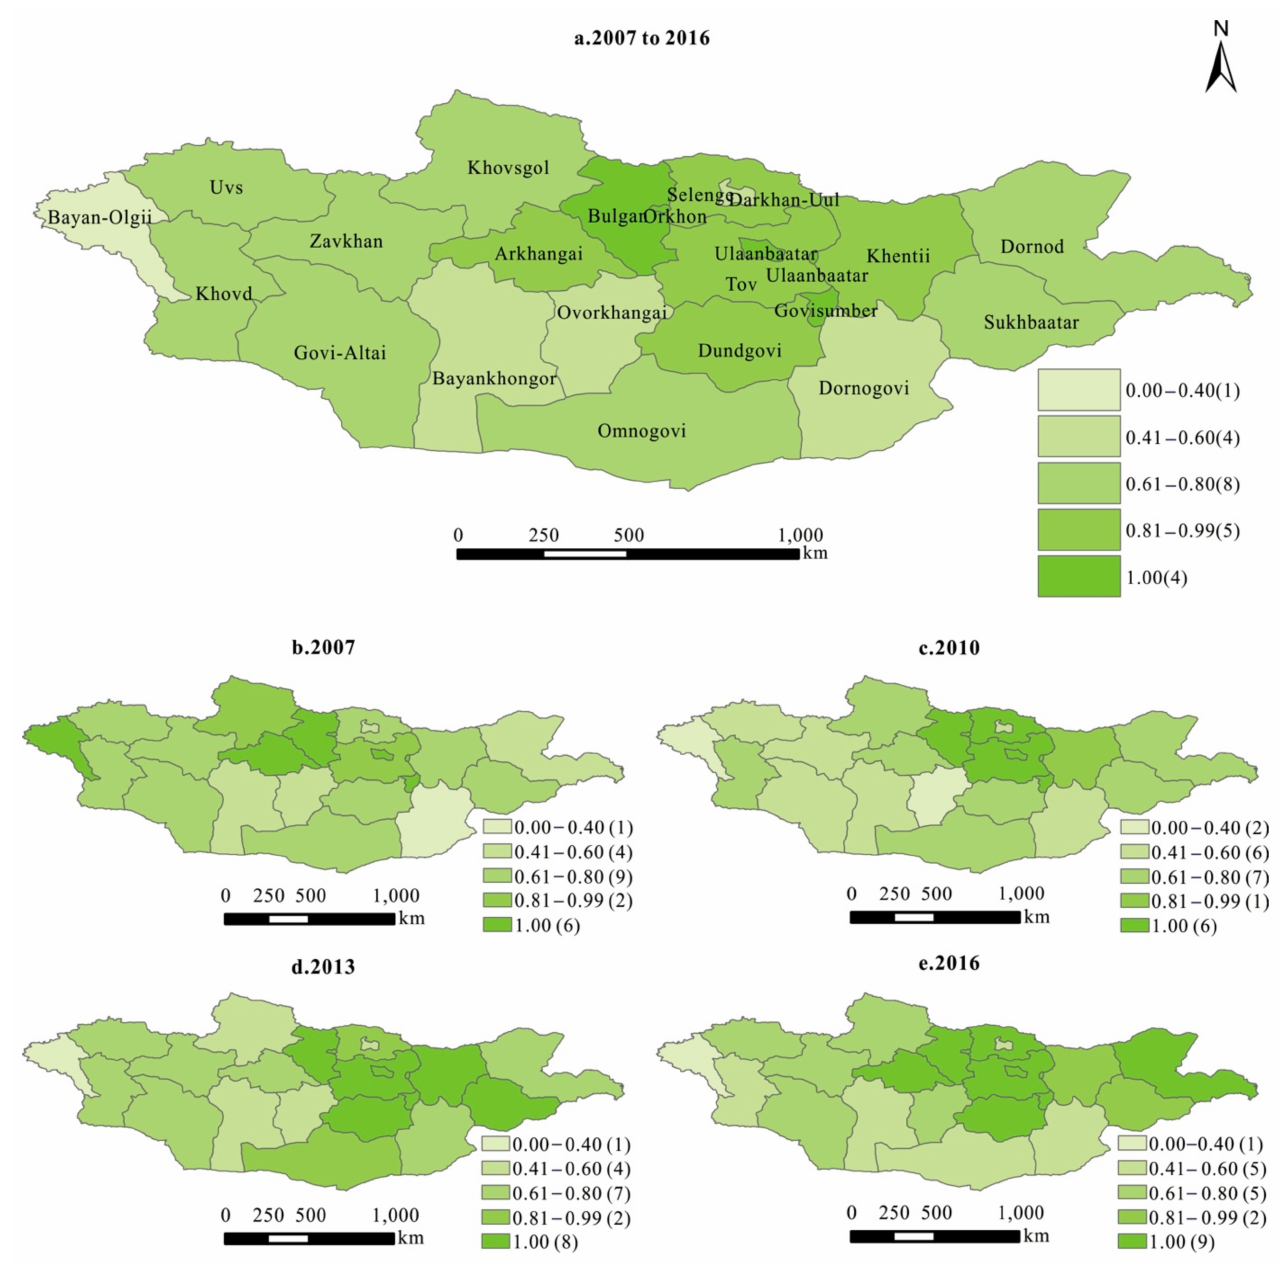
Figure 3. The spatial pattern of eco-efficiency in